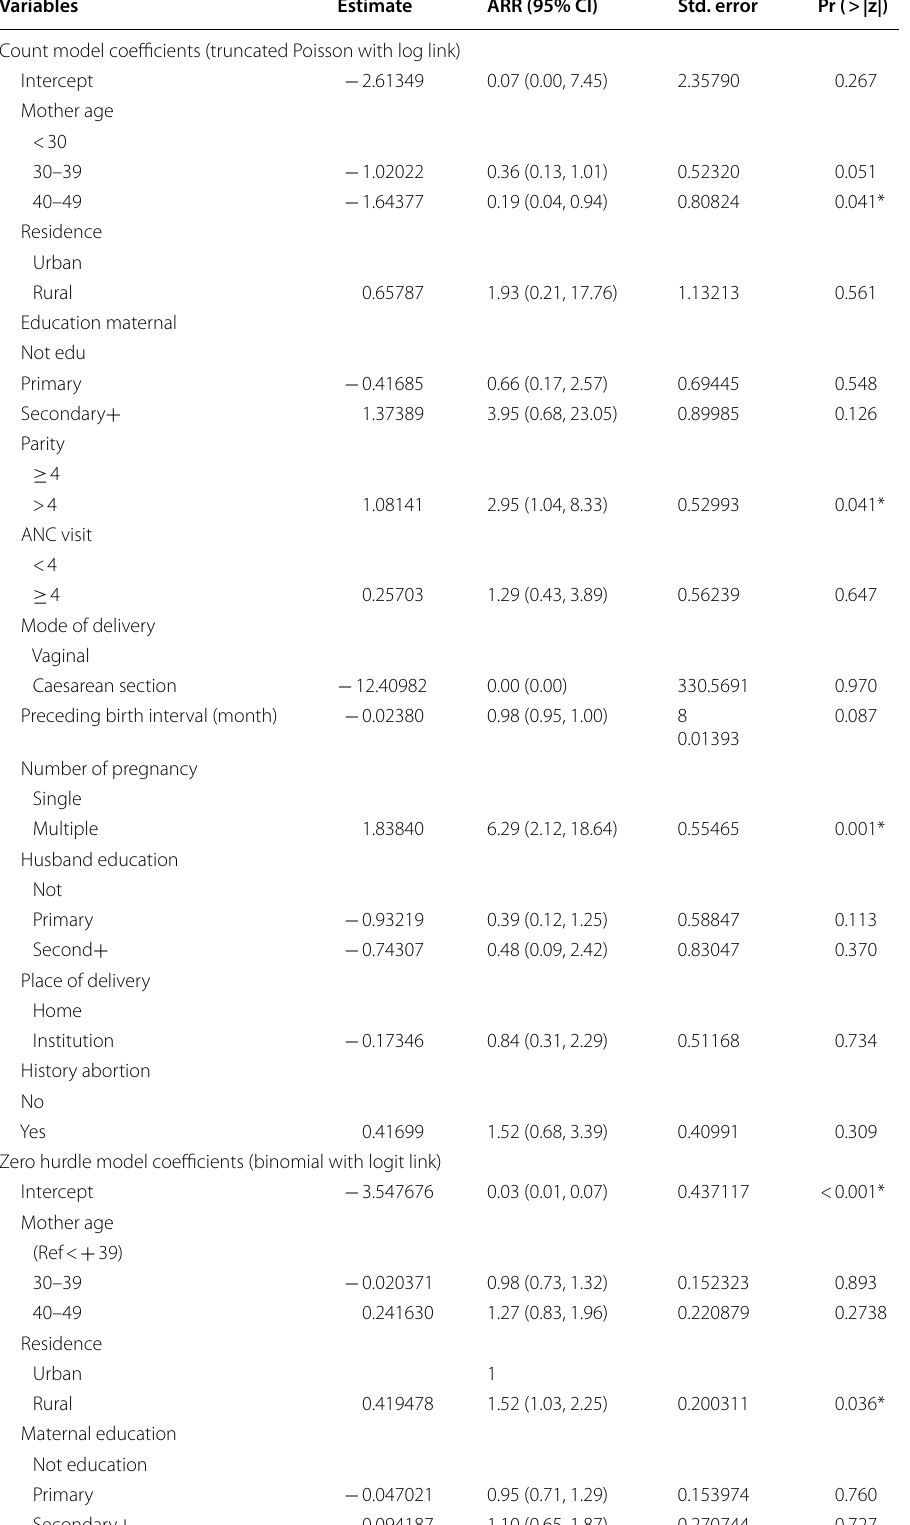
Table 1 Results of Poisson logistics hurdle model estimation